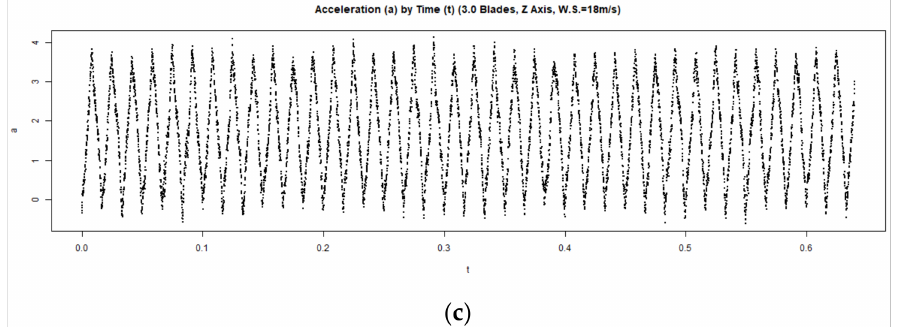
Figure A1. Acceleration signals recorded for the full (normal) 3.0-blade turbine. ( a ) Data recorded along the X axis with different wind-speeds imposed. ( b ) Data recorded along the Y axis with different wind-speeds imposed. ( c ) Data recorded along the Z axis with different wind-speeds imposed.